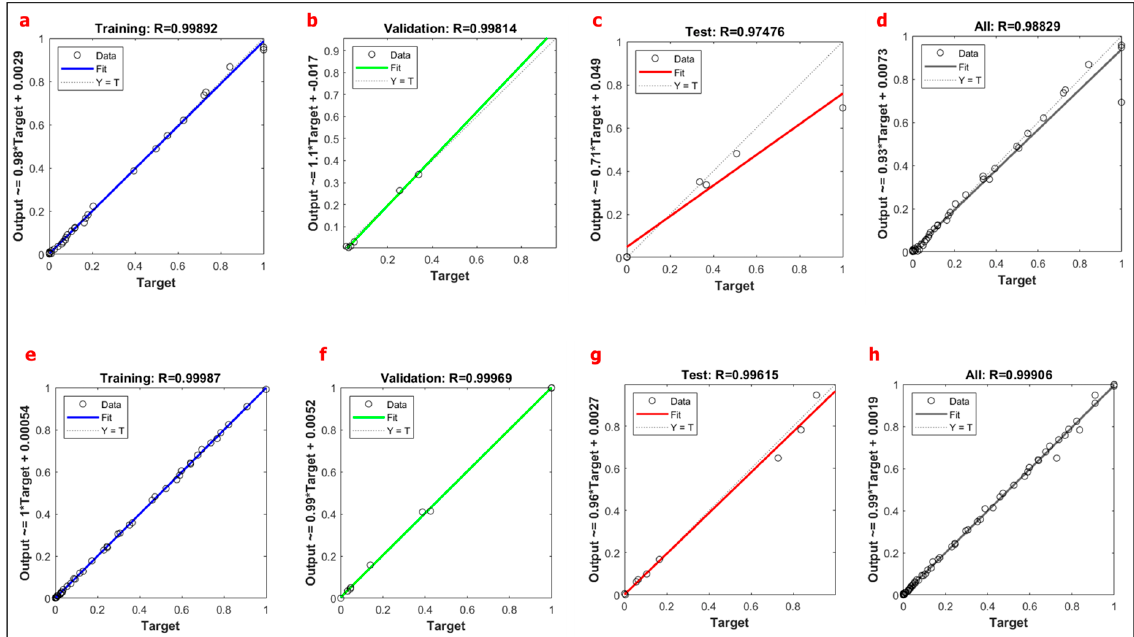
Figure 5. Regression plot obtained using ANN: ( a – d ) RW dryer and ( e – h ) convective